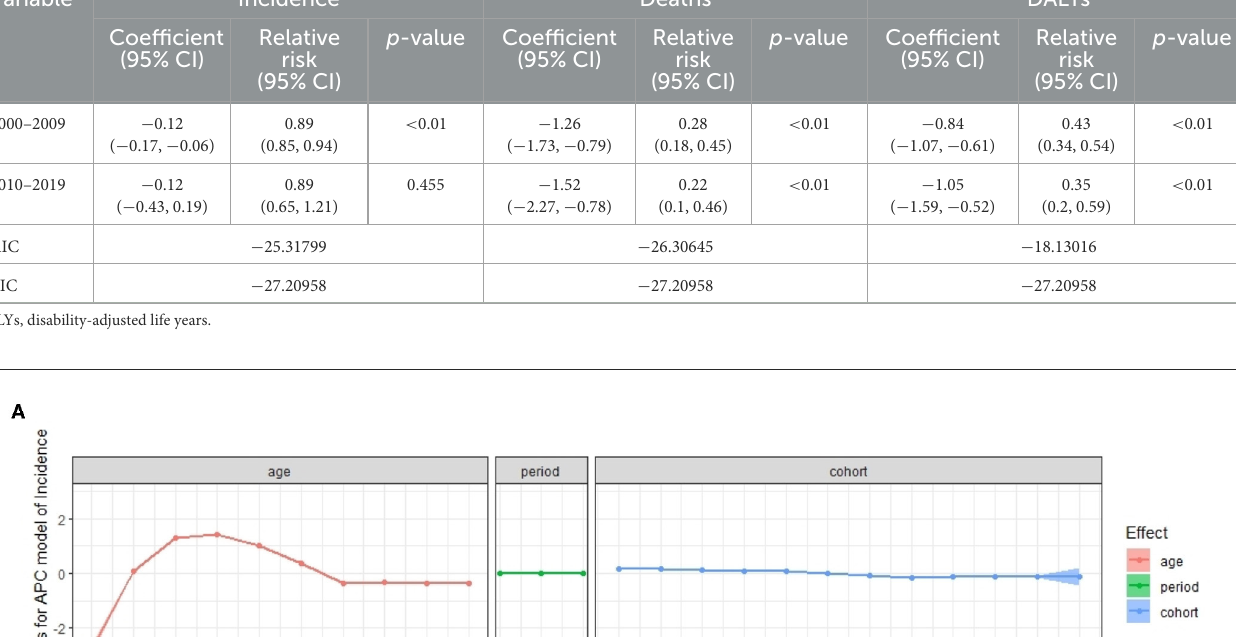
rates. In addition, the disease prediction models used in the database lack robust covariates for a more reliable risk assessment of the population (11). A second major limitation is that models are based on superimposed assumptions of age, period, and cohort